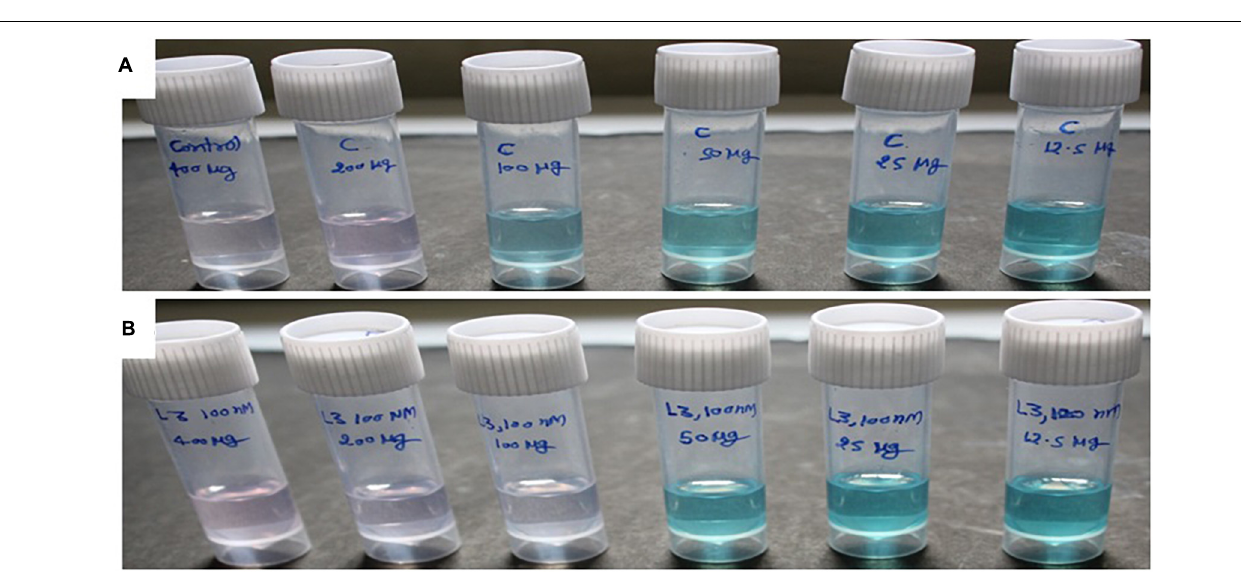
FIGURE 2 | The ABTS + radical scavenging method-based antioxidant activity of crude compounds in increasing concentration ( µ g/ml) isolated from D. longicolla (A) non-treated control and (B) BRD4770-treated cultures.